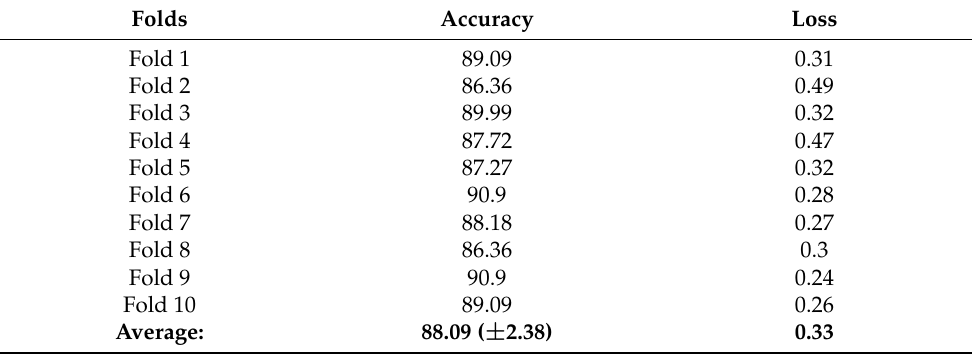
Table 7. Runs of 10-fold cross-validation for the VGG-16. Folds